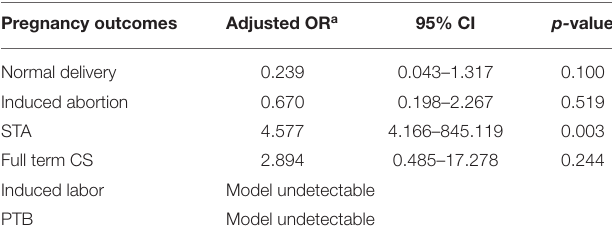
TABLE 3 | The ORs of pregnancy outcomes in post- AOSD